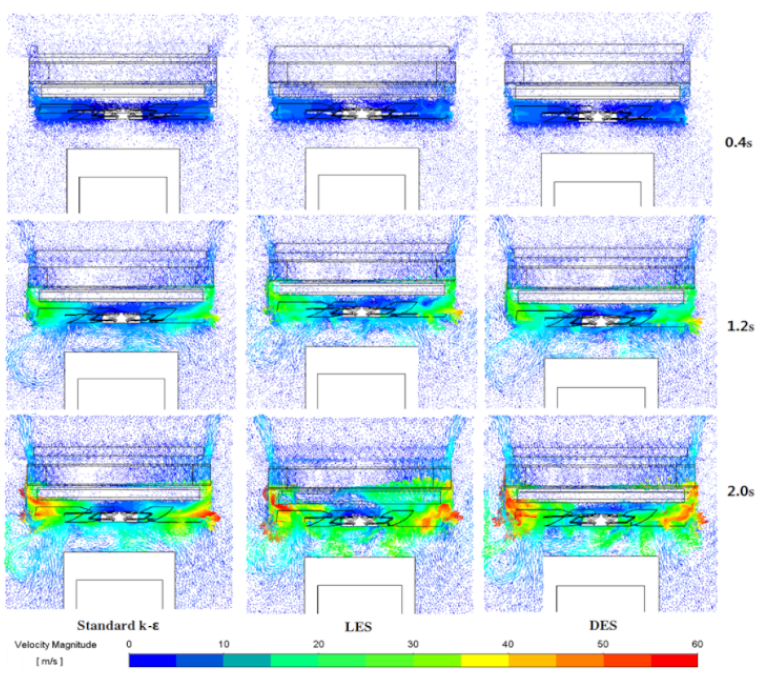
Figure 8. 2D contours of velocity magnitude at XY